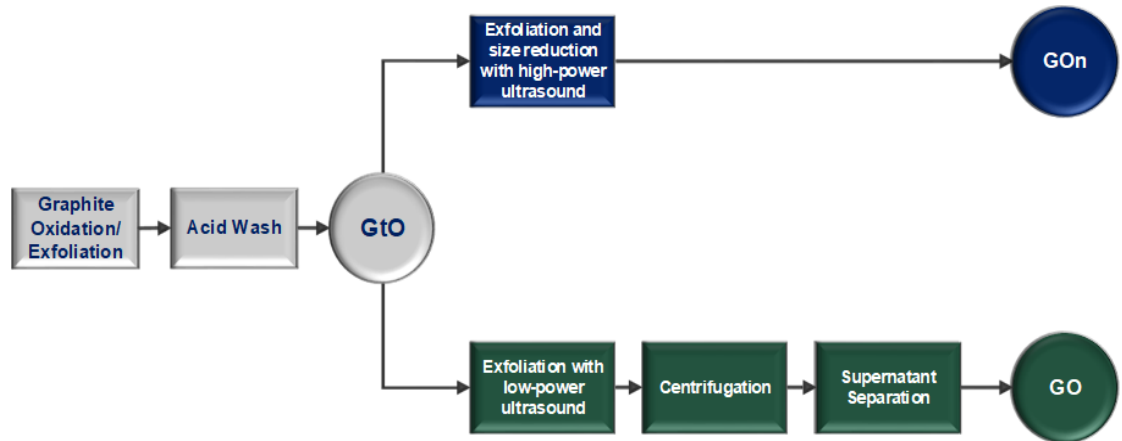
Figure 2. Flow diagram for the new high-power ultrasound method and the conventional centrifugation method for production of GO with small lateral dimensions.